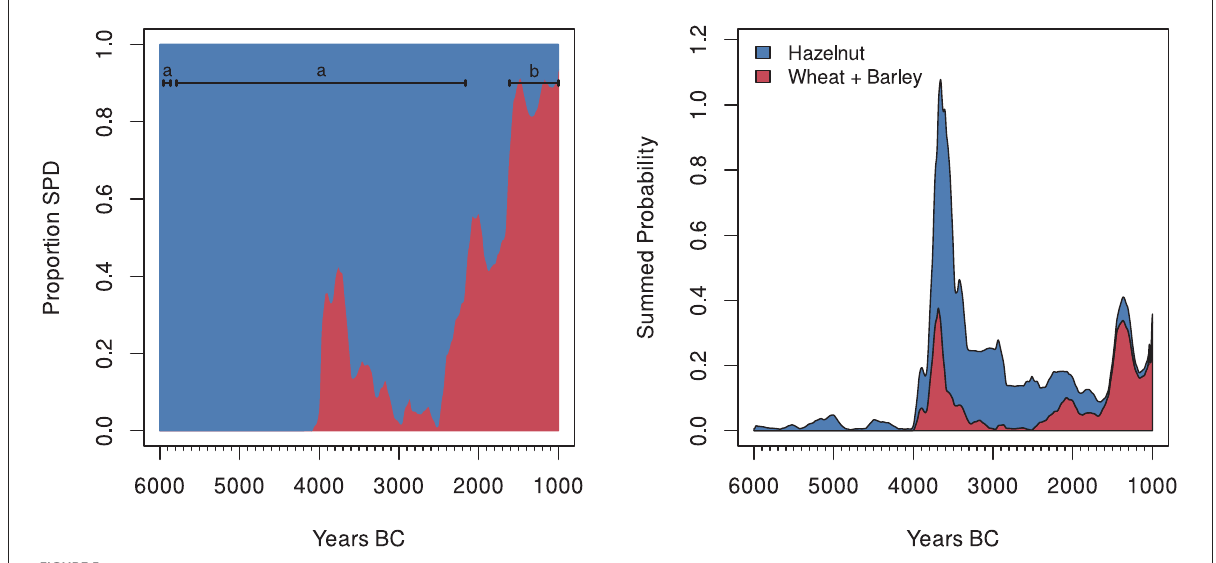
FIGURE5 Direct radiocarbon dates on hazelnuts and cereal grains from Britain (excluding the Scottish Isles) (Right panel) summed probability distribution of radiocarbon dates from hazelnut ( n = 542) and wheat/barley ( n = 285). (Left panel) relative proportion of dates with time-intervals with significantly higher proportion of hazelnut (a) and wheat/barley (b) obtained from a mark permutation test with 1,000 iterations. Sample size take into account dates with cumulative calibrated probability above 0.5 between 6,000 and 1,000 BC (Data from Bevan et al.,